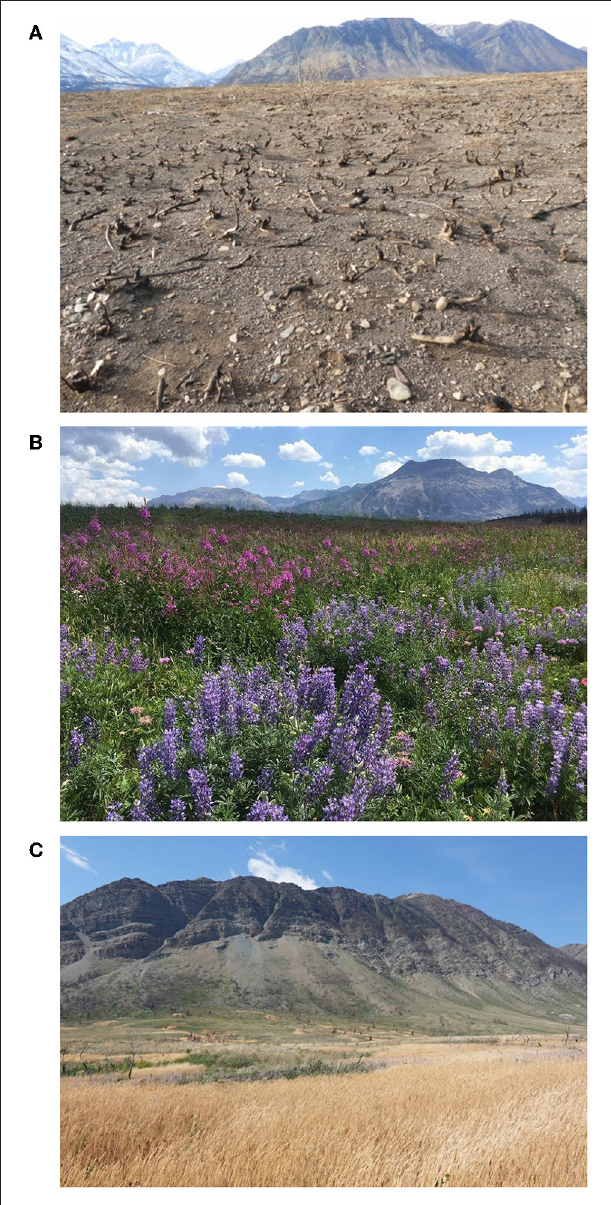
FIGURE 3 | (A–C) Aftermath of the Kenow wildfire, Eskerine Complex Waterton Lakes National Park, Fall 2017/Summer 2018 photographs. (A) Eskerine Complex aspen stand, post Kenow wildfire, fall 2017 (Ryan Peruniak); (B) Eskerine Complex prairie vegetation response, July 2018 (Angela Cook); (C) Calamagrostis response, Eskerine Complex (Cristina